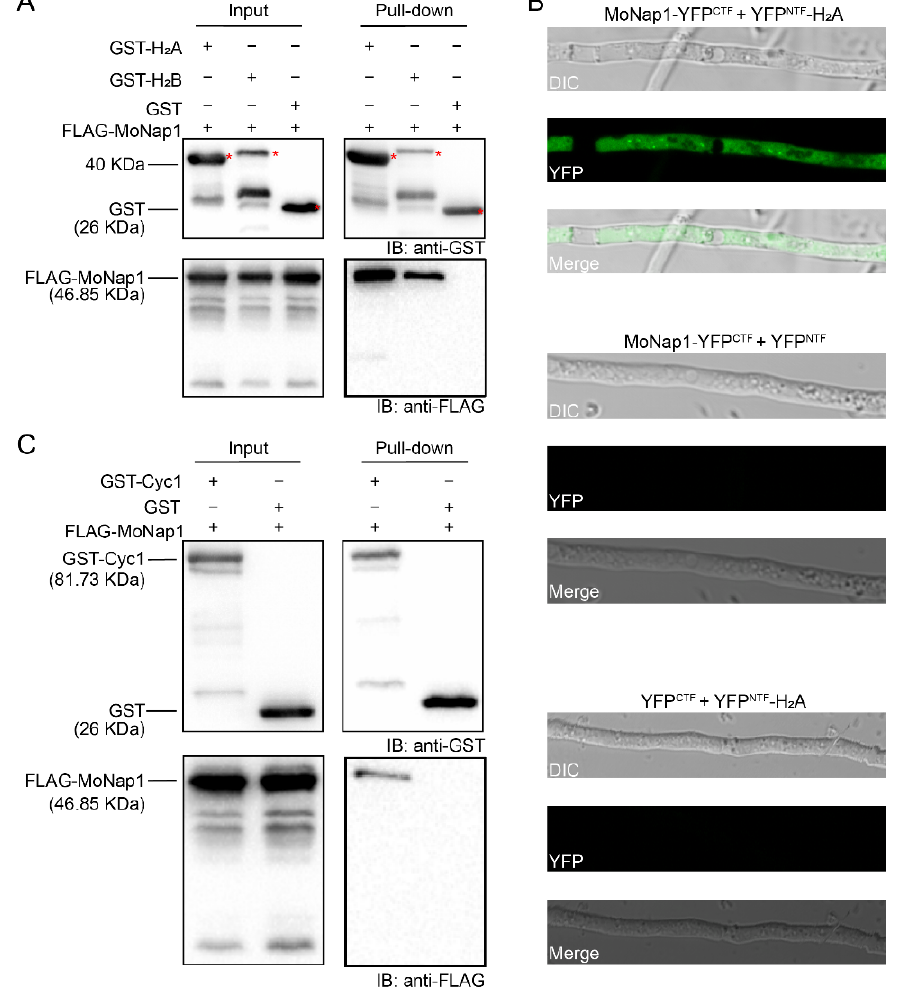
Figure 8. MoNap1 interacted with H 2 A, H 2 B, and Cyc1. ( A ) Pull-down results between FLAG- MoNap1 and GST-H 2 A or GST-H 2 B in E. coli BL21. FLAG-MoNap1 was detected in GST-H 2 A and GST-H 2 B eluents but not in GST eluents. Asterisks represent the bands of GST-H 2 A (41.27 kDa) or GST-H 2 B (42.82 kDa). ( B ) Visualization of the MoNap1-H 2 A interaction using a BiFC assay. YFP signals were observed in vegetative hyphae in the transformant harboring MoNap1-YFP CTF and YFP NTF -H 2 A. No detectable YFP signals were observed in the negative control transformants harboring MoNAP1-YFP CTF and YFP NTF or YFP CTF and YFP NTF -H 2 A. ( C ) Pull-down results between FLAG-MoNap1 and GST-Cyc1. FLAG-MoNap1 was detected in the GST-Cyc1 eluent but not in the GST